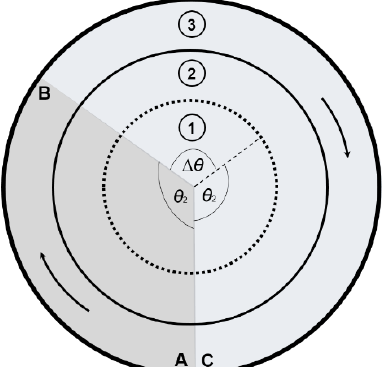
Figure 3. Timing profile of the device from seedlings pick to drop: ( θ 2 ) crank rotational angle, (∆ θ ) cam rotational angel, (A) pick the seedlings, (B) change y -axis to x -axis, and (C) drop the seedlings. The gripper position for the y -axis movement is controlled by a vector-loop model and a slider-crank mechanism with three bars ( L 2 , L 3 , and L 4 ) [36,37]. The vector loop of the picking device can be expressed as Equation (2).